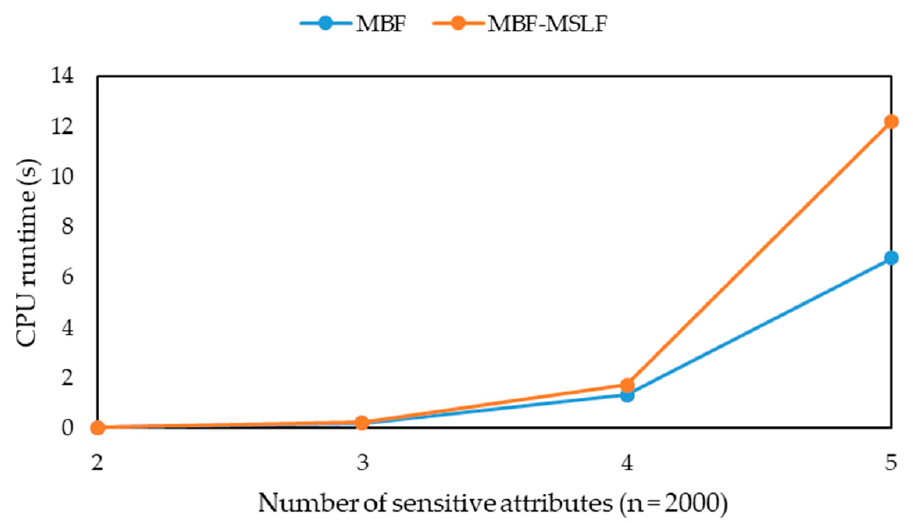
Figure 7. The CPU runtime of MBF and MBF-MSLF with different sensitive attribute numbers ( n = 2000).